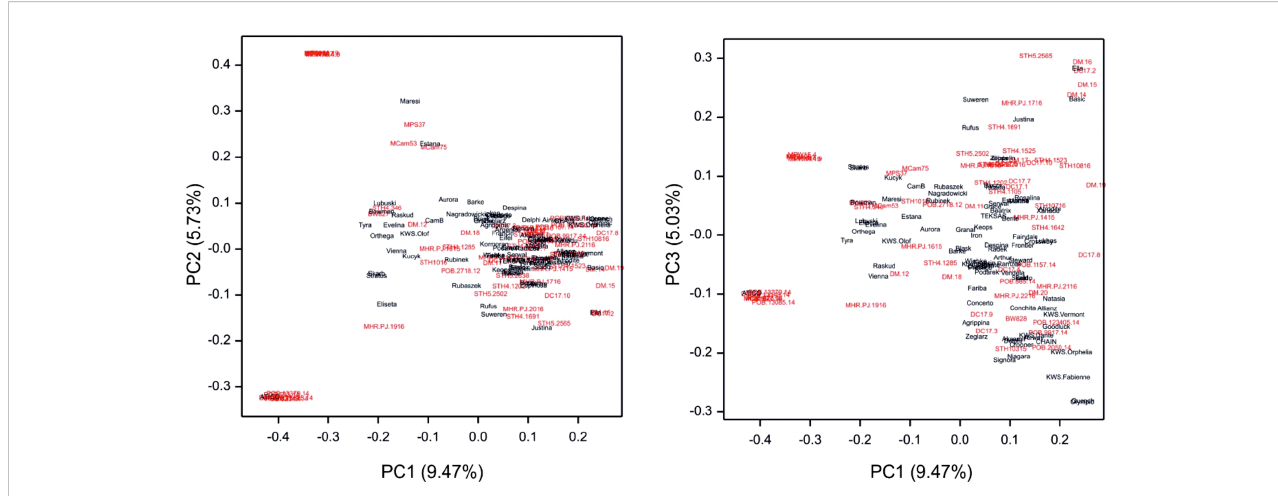
FIGURE 4 Visualization of the population structure by PCoA of the kinship coef fi cient matrix for accessions (cultivars – black, breeding lines – red) based on SNP markers. Cultivar accessions were grouped on the right side and evenly distributed groups of breeding lines overlapped with the subgroups of